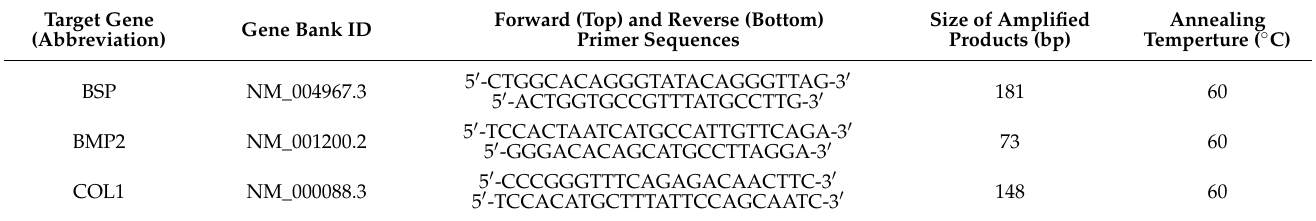
Table 1. Primer sequence, product size, annealing temperature, for quantitative reverse transcription polymerase chain